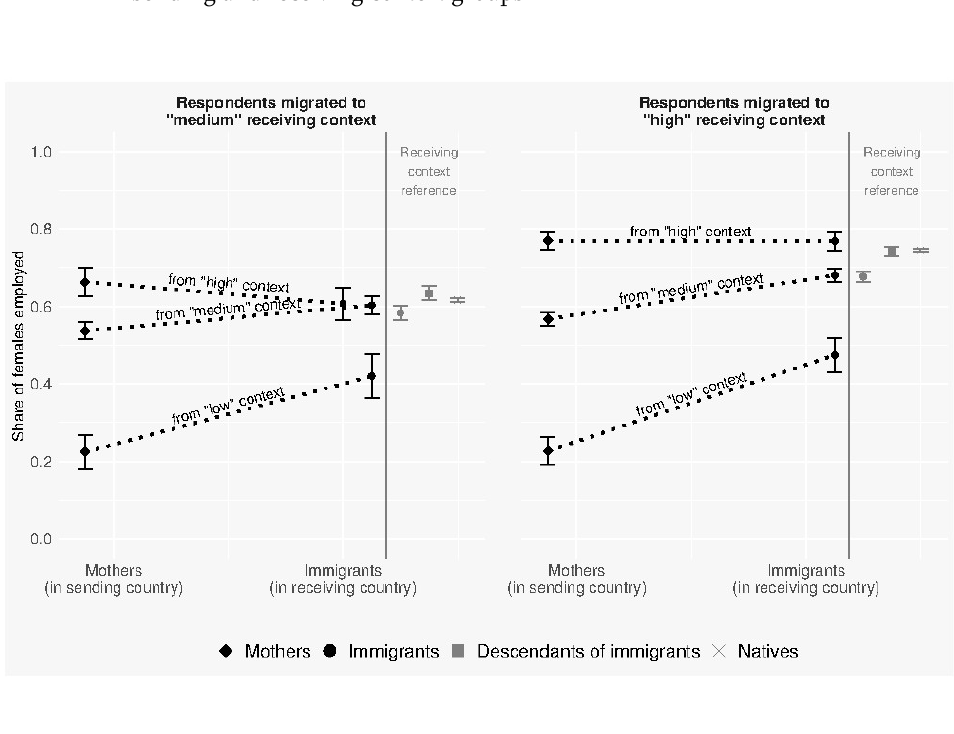
Figure 3 : Employment rates for female immigrants in the ESS and their mothers by sending and receiving context